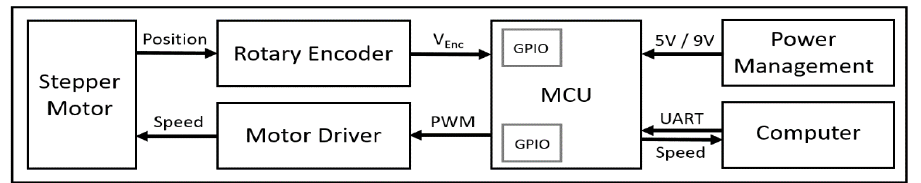
Figure 2. Overall block diagram of electrical system of the grasshopper treadmill.